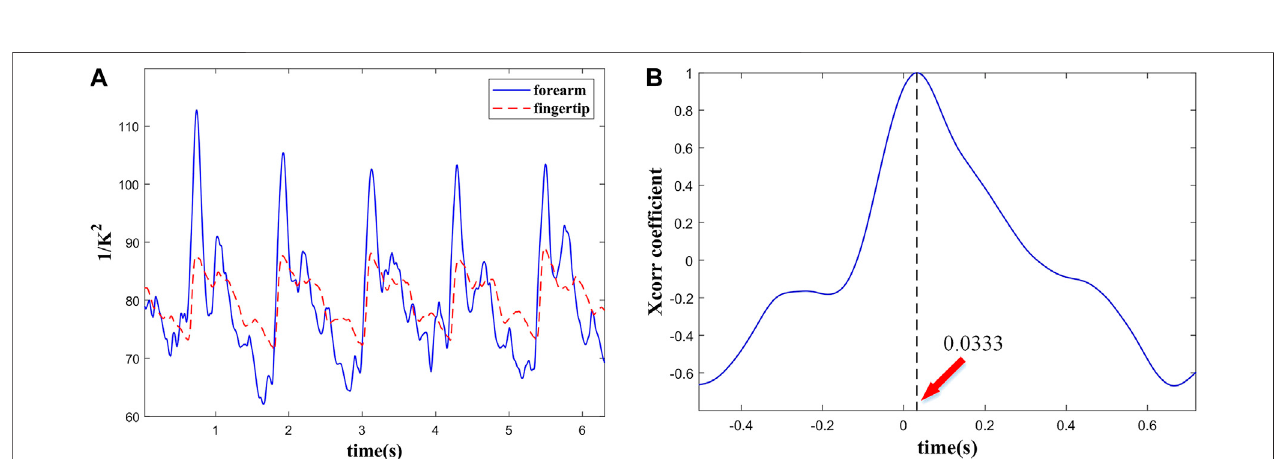
FIGURE 5 | (A) Simultaneous recording of pulse wave from the forearm and the fi ngertip and (B) PTT between them.